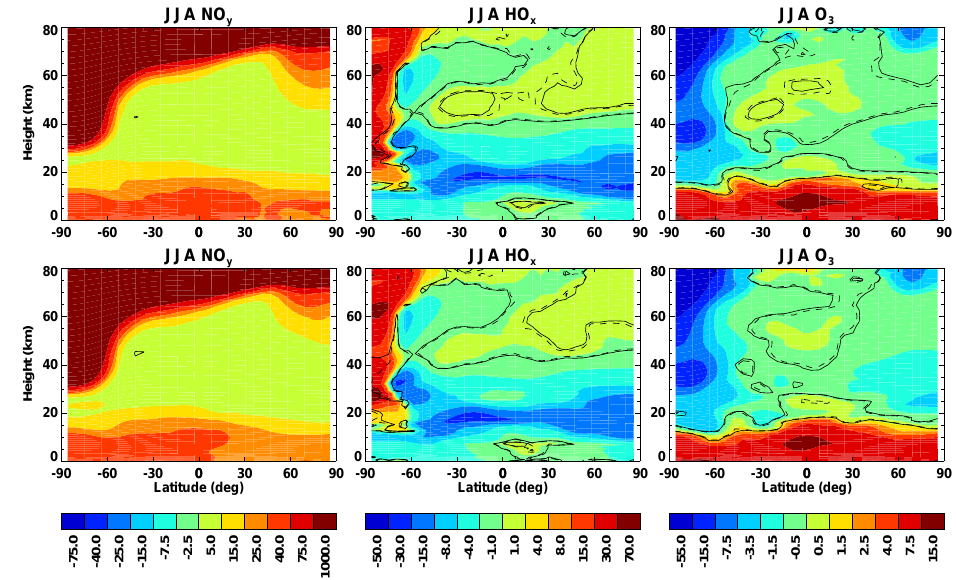
Fig. 13. As in Fig. 12 but for NO y (left, %), HO x (center, %) and O 3 (right, %).